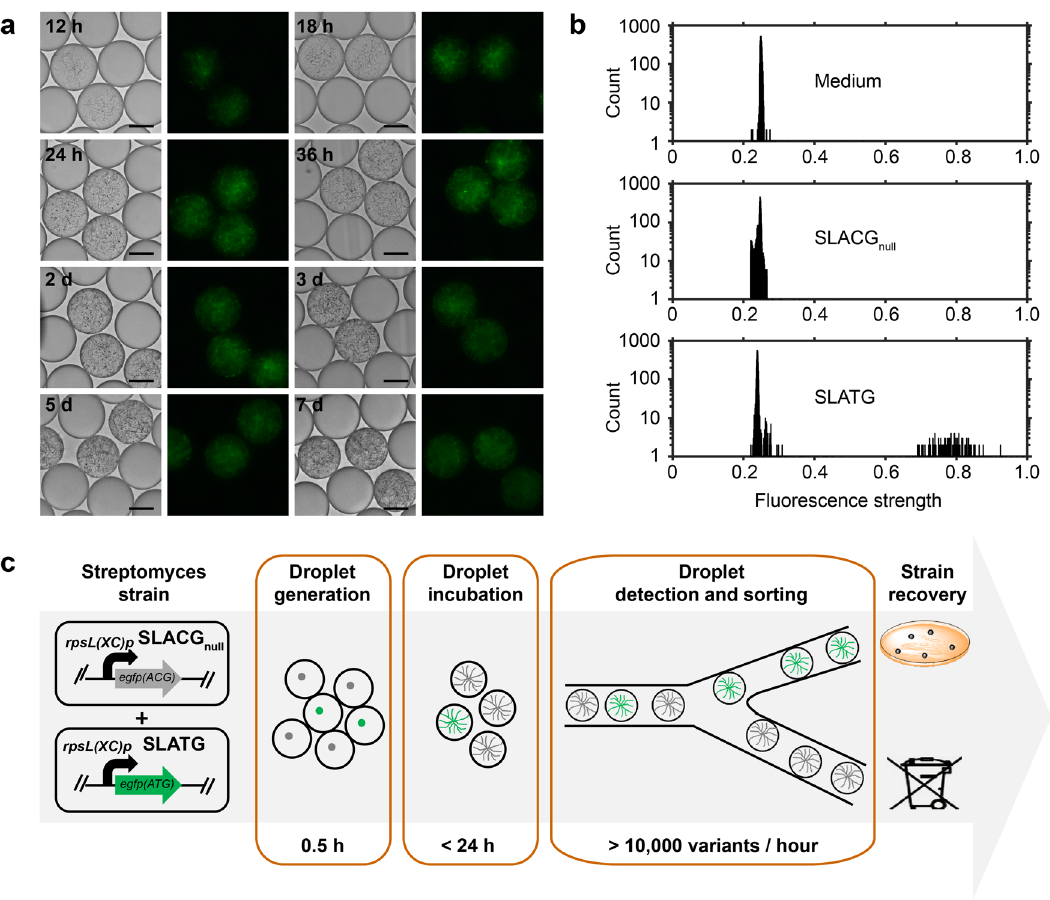
Fig. 2 Use of FADS for Streptomyces detection and screening. a Detection of fl uorescent signal of SLATG (green fl uorescence-positive strain) in pL-range droplets at different time points. Scale bar: 50 μ m. The exposure time was 50 ms. b Histogram of signals of medium, SLACG null (green fl uorescence- negative strain), and SLATG by droplet-based micro fl uidics. Each sample included at least 5000 droplets for the analysis. c Flow chart of Streptomyces detection and screening using FADS.